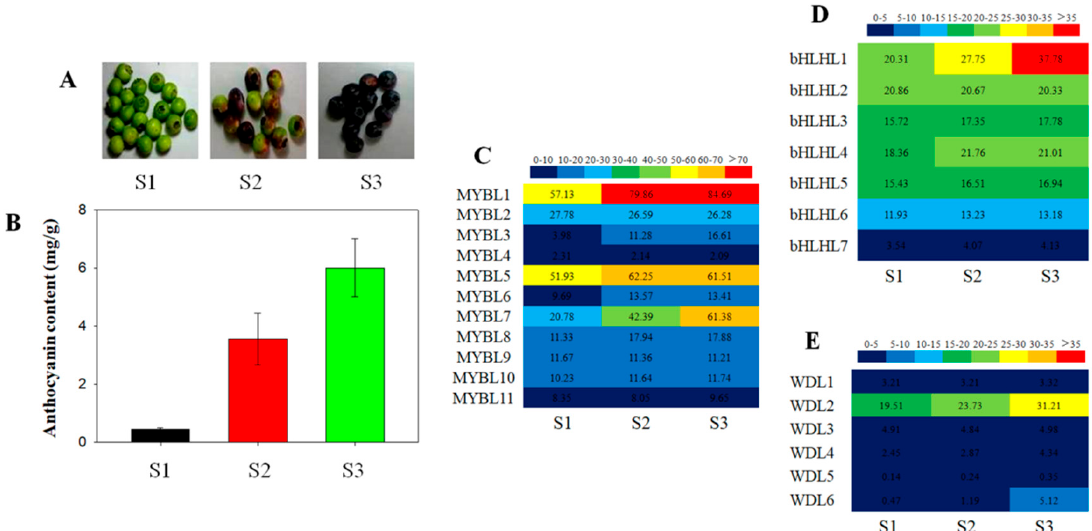
Figure 2: Expression analysis of MYB-bHLH-WD40 complex gene family members in blueberry fruits. ( a ) Blueberry fruit developmental stages. S1, green fruits; S2, pink fruits; S3, blue fruits. ( b ) The content of anthocyanins in blueberry fruits. Error bars are standard errors of the mean from three technical replicates. ( c ) Expression analysis of MYB families. ( d ) Expression analysis of bHLH families. ( e ) Expression analysis of WD40 families. Grids with eight different colors from blue to red show the RNA-seq fragments per kilobase per million reads (FPKM) values.